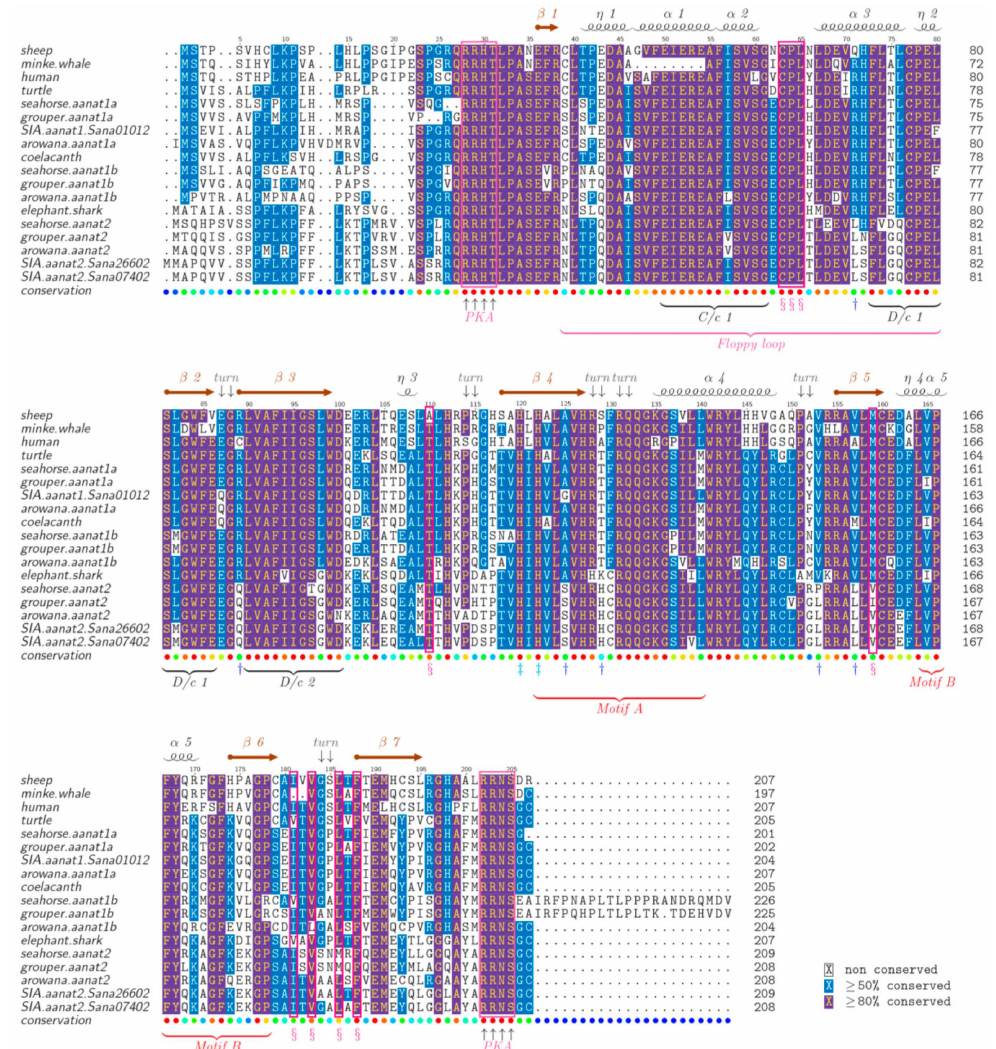
Figure 4. Alignment of AANAT protein sequences. AANAT proteins from different species were aligned with sheep AANAT and the structural template 1CJW. The analysis was completed with MAFFT and colorized using TEXshade. Secondary structures include alpha helix ( α ), beta strand ( β ), and 3 10 helix ( η ). Important residues, including substrate binding residues (§, red boxes), catalytic residues (‡) and phosphorylation sites (up arrow, pink boxes), are marked for comparison. Residues differentiating between AANAT1 and AANAT2 are marked by a dagger (†). Numbering is relative to sheep AANAT. The color code for the conservation track ranges from red for the most conserved, to blue for the least conserved, as per